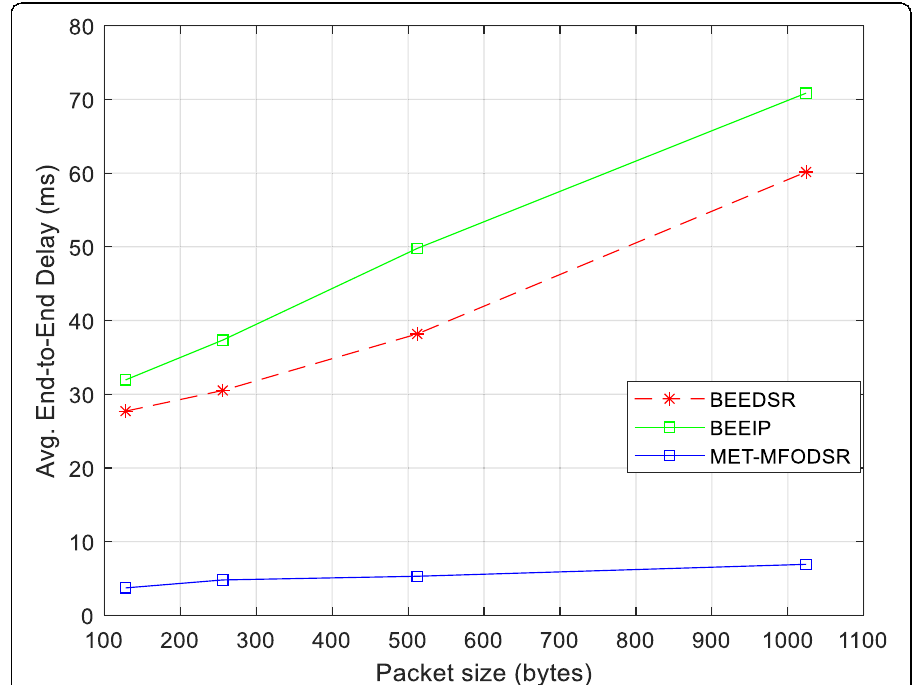
Fig. 5 Average end-to-end delay simulation results for BEEDSR, BeeIP, and MET-MFODSR. The simulation results of the average delay under the packet size